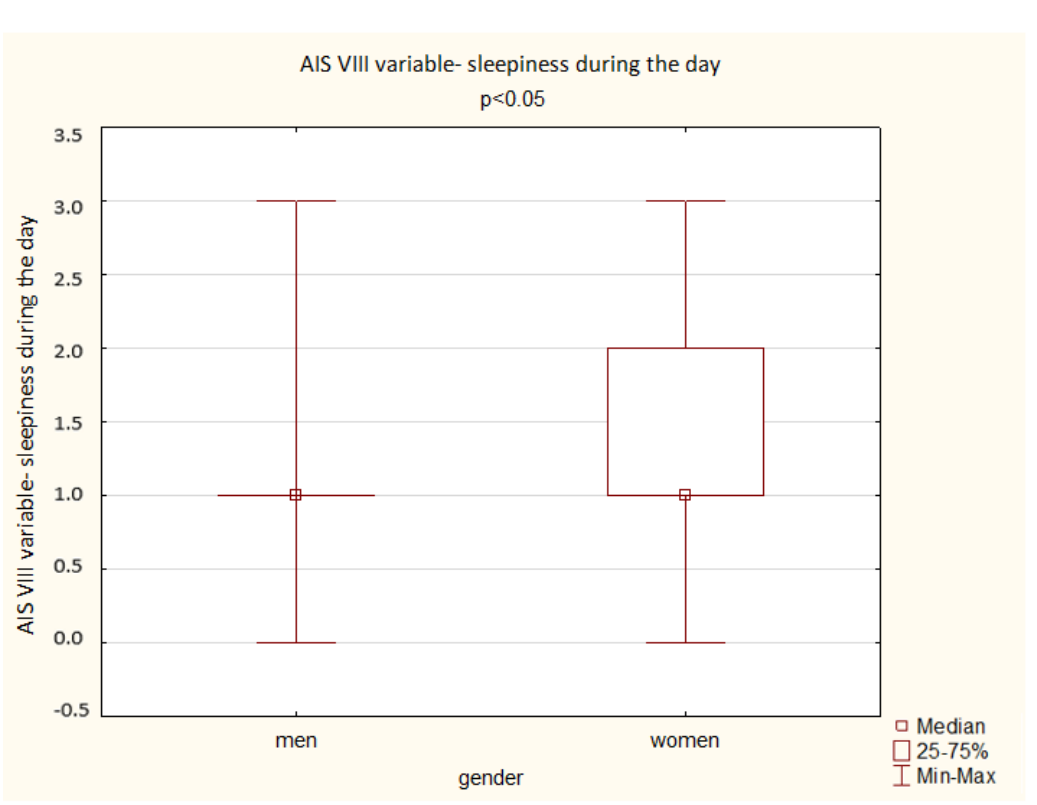
Figure 5. Patient results in the AIS VII variable—physical and mental fitness the next day (Mann– Whitney U test).